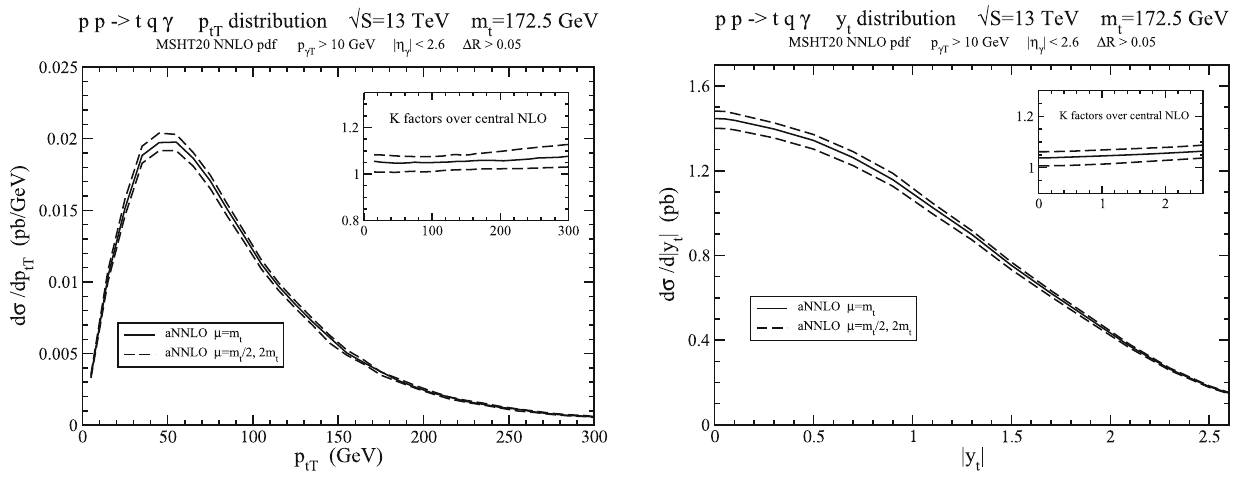
Fig. 7 The aNNLO top-quark p T (left) and rapidity (right) distributions in tq γ production at 13 TeV LHC energy